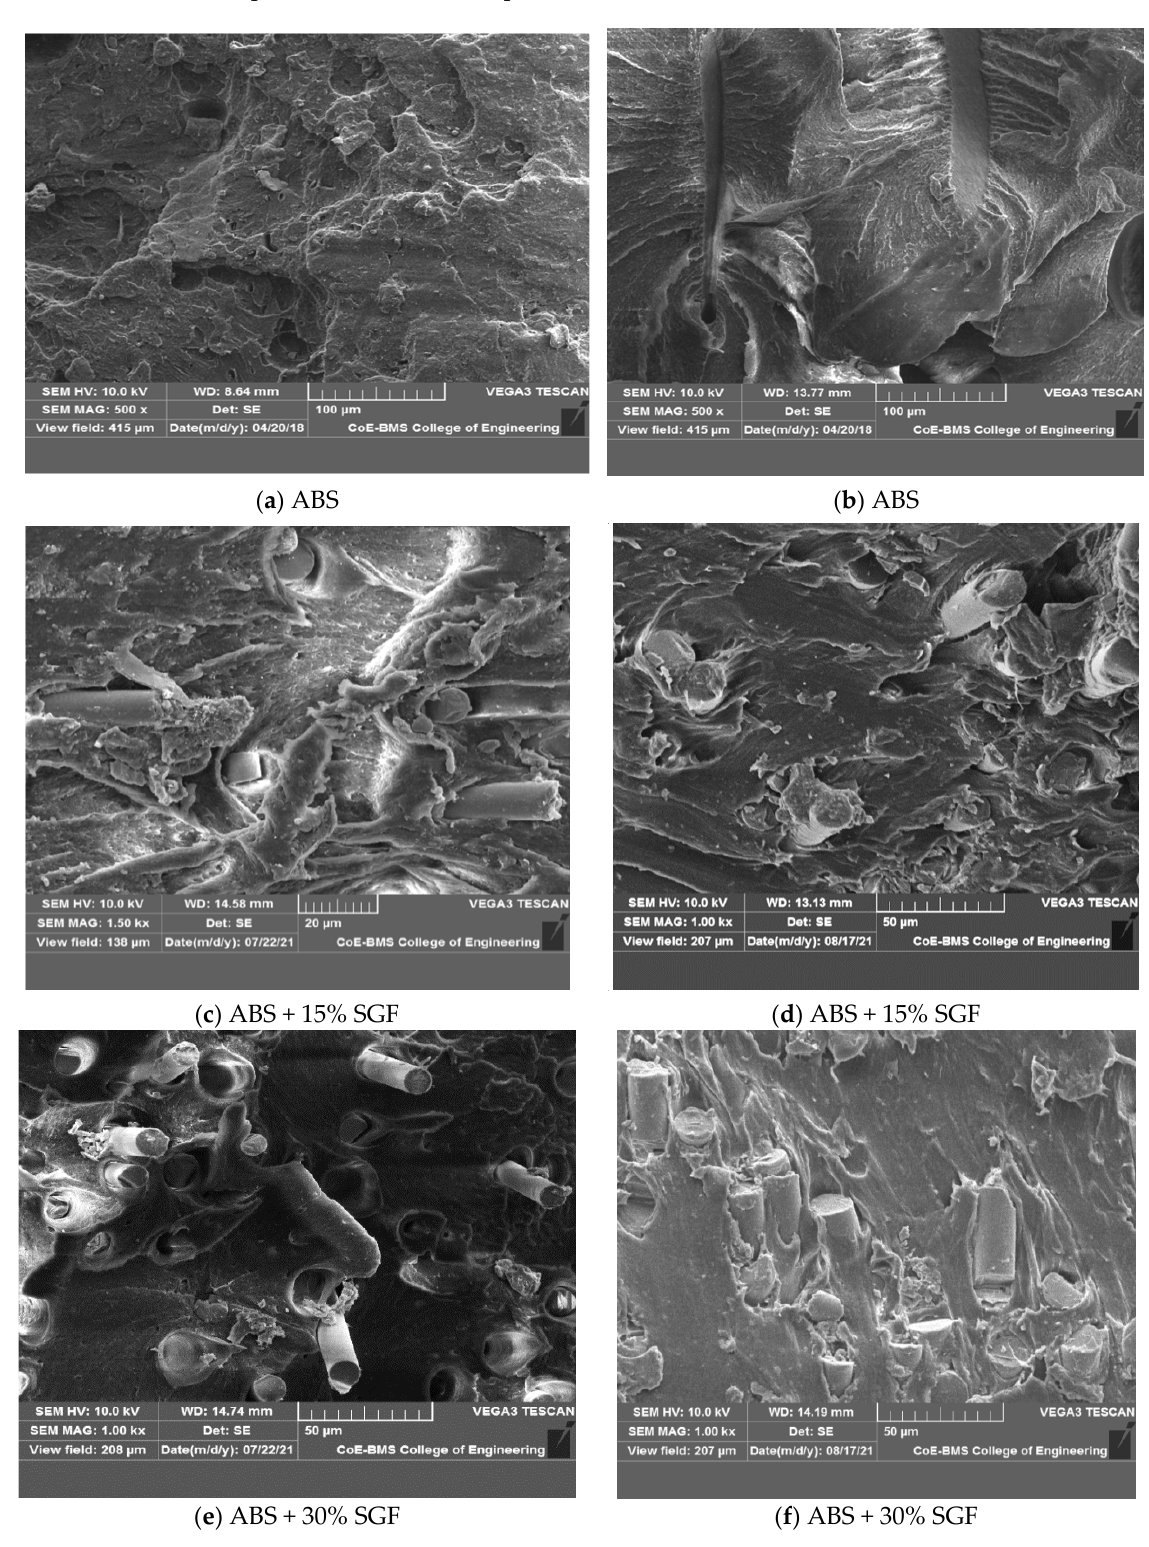
Figure 13. SEM of fractured tensile specimens of ABS, ABS + 15 wt% Glass fibre and ABS + 30 wt% glass fibre.